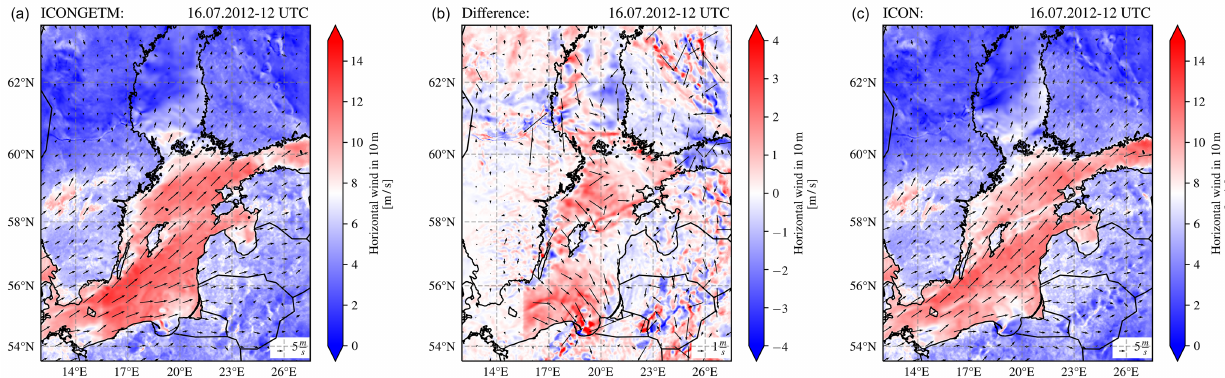
Figure 11. Horizontal wind field at 10m height from the two-way coupled ICONGETM simulation (a) and the uncoupled/one-way coupled ICON simulation (c) as well as the difference ICONGETM minus ICON (b) for 16 July 2012 12:00UTC. Displayed are the wind vectors (reference vector at the bottom of the figure, units of ms − 1 ) and the wind speed (coloured).